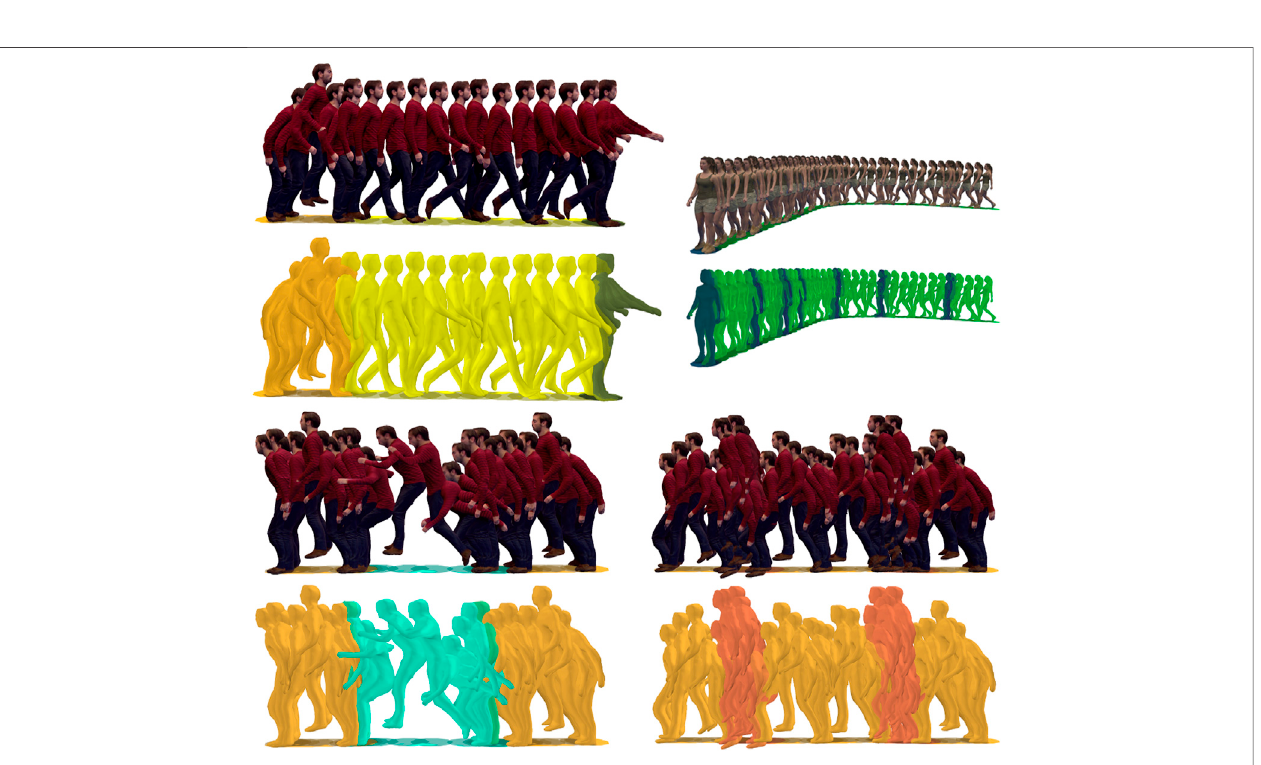
FIGURE9| Dan and Roxanne characters performingseveralanimations,top-left: transitionfrom jumptowalktoreach;top-right:from walktostand; bottom-left: from jump short to jump long; bottom-right: from jump short to jump high sequence. Mesh colours indicate motion sequences and the generated transitions.